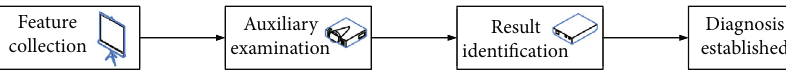
Figure 1: The diagnosis process of football